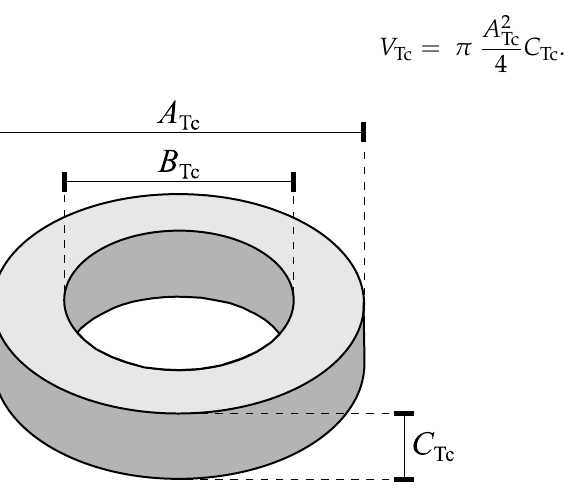
are introduced as parameters. As a measure of the required space regarding the system integration, the overall component volume V Tc is defined with the outer diameter A Tc and the height C Tc of the core as follows: